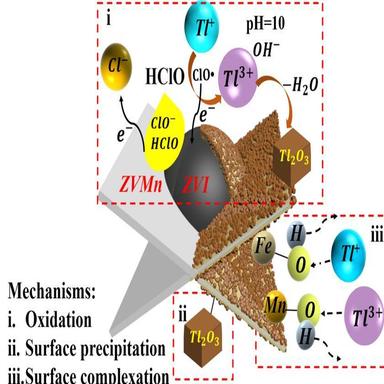
The mechanisms of Tl(I) removal using the nZVIM/ClO− approach.